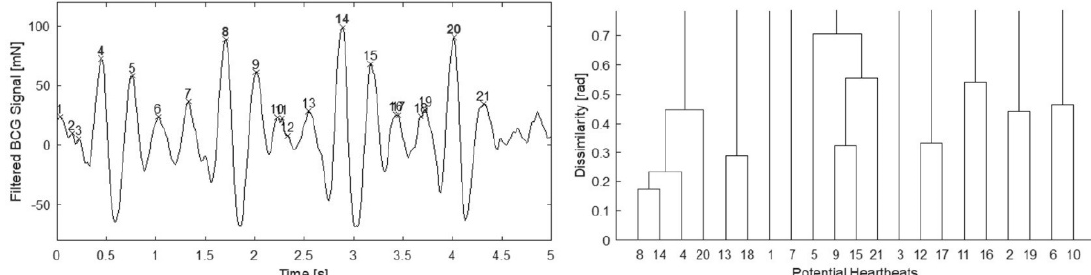
Figure 1. Cardiac signal peak detection and a dendrogram of hierarchical